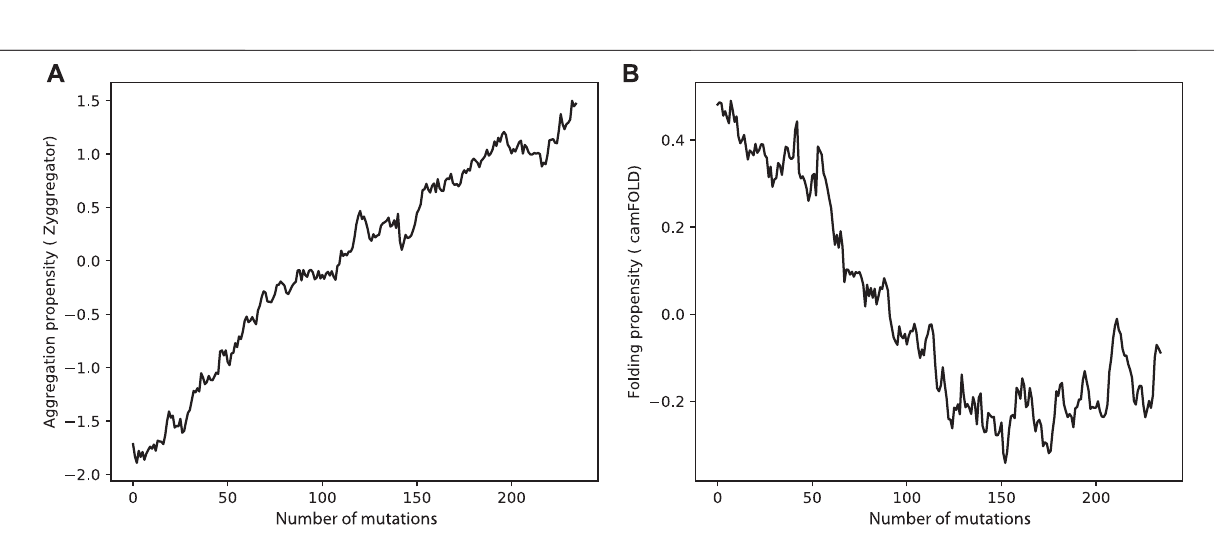
Frontiers in Molecular Biosciences |